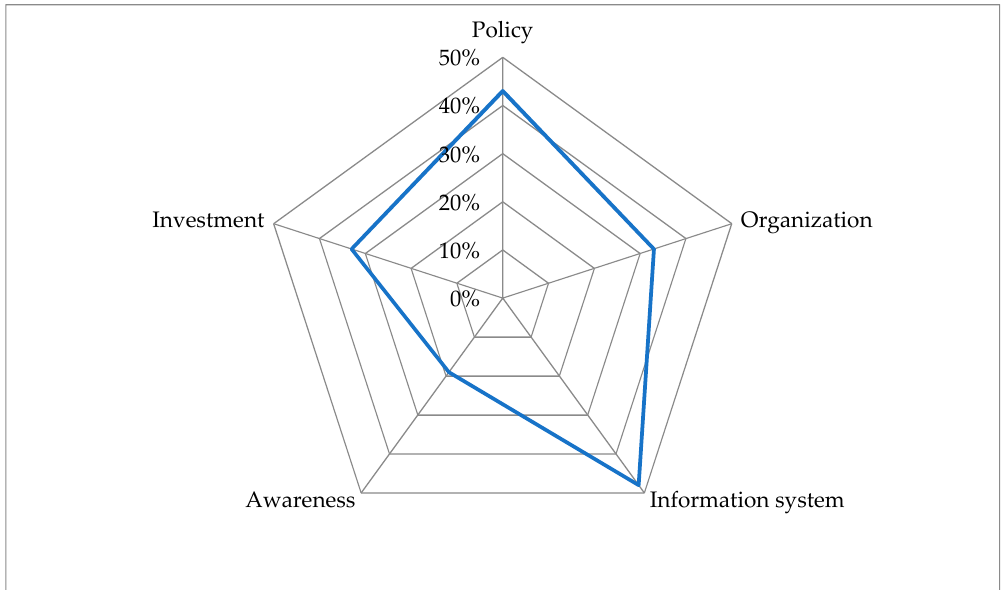
Figure 8. The matrix for assessing the energy management process in the textile industries of Bangladesh.